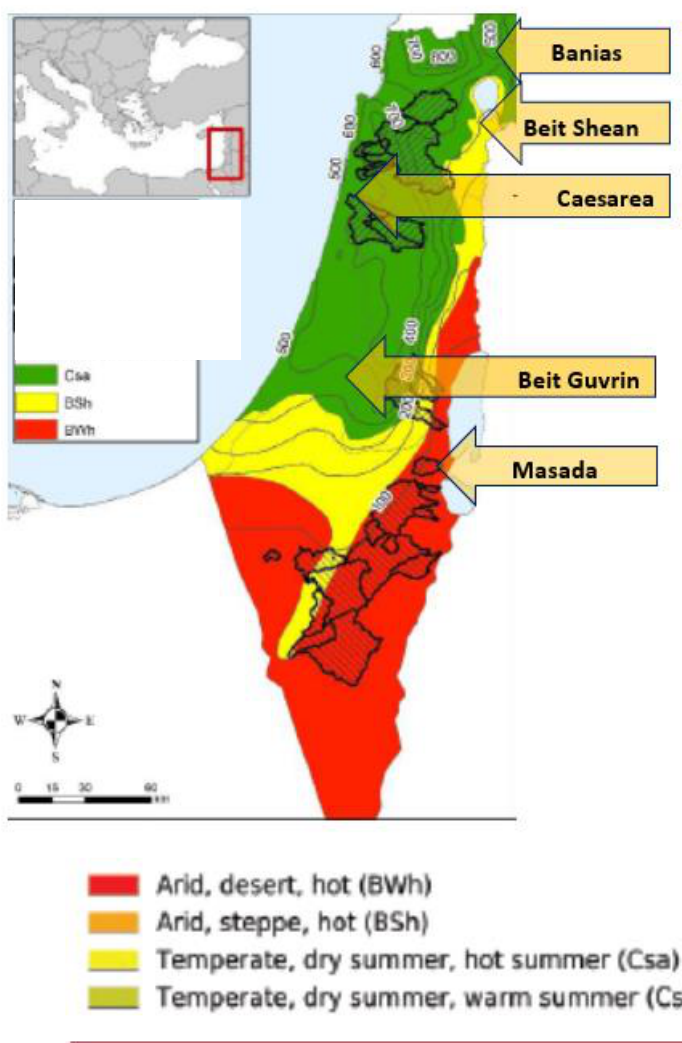
Figure 2. Köppen–Geiger climate classification from Survey of Israel (1970), mean annual precipita- tion (1981–2010, Israel Meteorological Services) (Source: [31]).